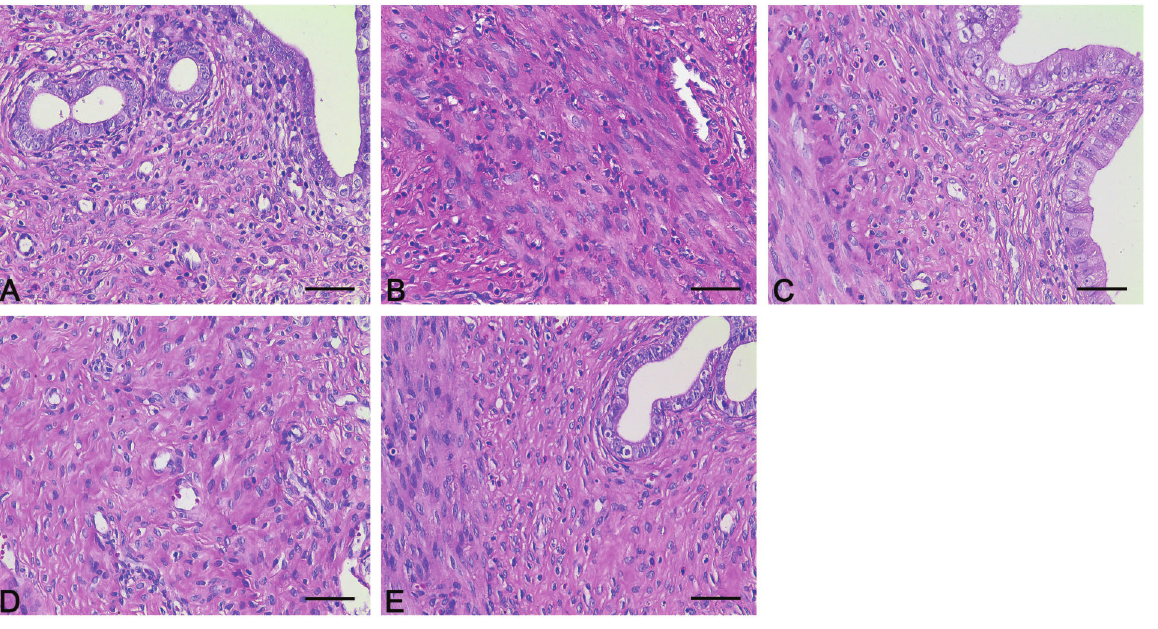
Figure 2. Pathologic changes in uterine leiomyomas tissue. Endometrium in NCG ( A ) and QSABSG ( D ) were intact with no hyperplasia, atrophy, edema, denaturation or necrosis. In CDWSG ( E ) and LTMG ( C ), the endometrial epithelial cells had vacuolar degeneration, the smooth muscle cells had focal proliferation and hyaline degeneration, and the muscle was in fi ltrated by in fl ammatory cells. In STMG ( B ), uterine smooth muscle cells had little hyaline degeneration, and muscle layer had in fl ammatory cells. NCG: normal control group; STMG: short-term model group; LTMG: long-term model group; QSABSG: Qi stagnation and blood stasis group; CDWSG: combining disease with syndrome group. Magni fi cation bar: 50 m m.